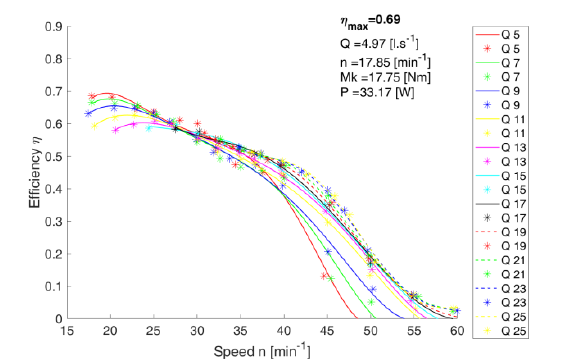
Fig. 8. Efficiency for configuration, bucket 00 and channel edge position -40 for different flow rates.